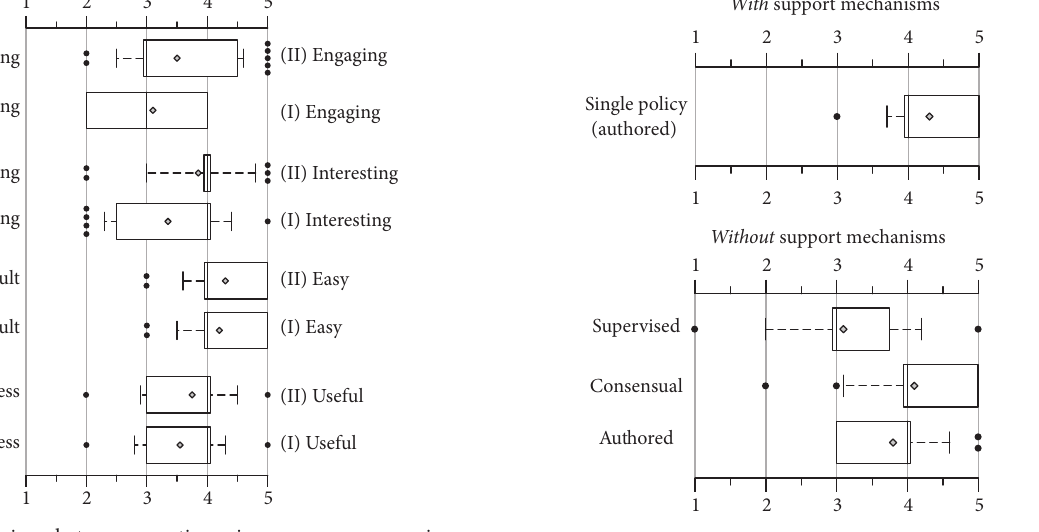
Figure 8: Comparison of satisfaction with resulting annotations between the evaluations with and without support